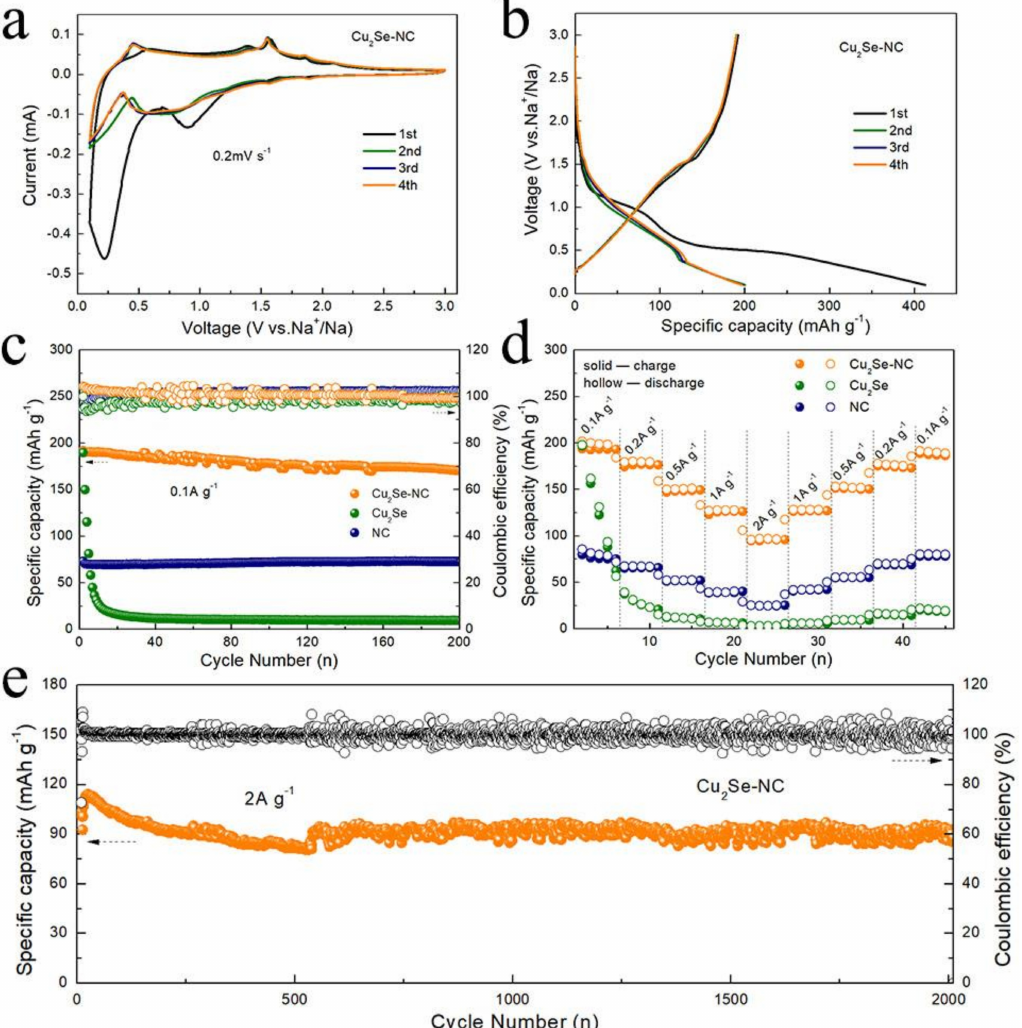
Figure 3. ( a ) Cyclic voltammograms of the Cu 2 Se–NC for the initial four cycles; ( b ) Charge / discharge curves of the Cu 2 Se–NC; ( c ) Cycling performance and of the Cu 2 Se–NC and Cu 2 Se and NC at 0.1 A g − 1 ; ( d ) Rate capability of the Cu 2 Se–NC at various current densities; ( e ) Long cycling performance of the Cu 2 Se–NC at 2 A g − 1